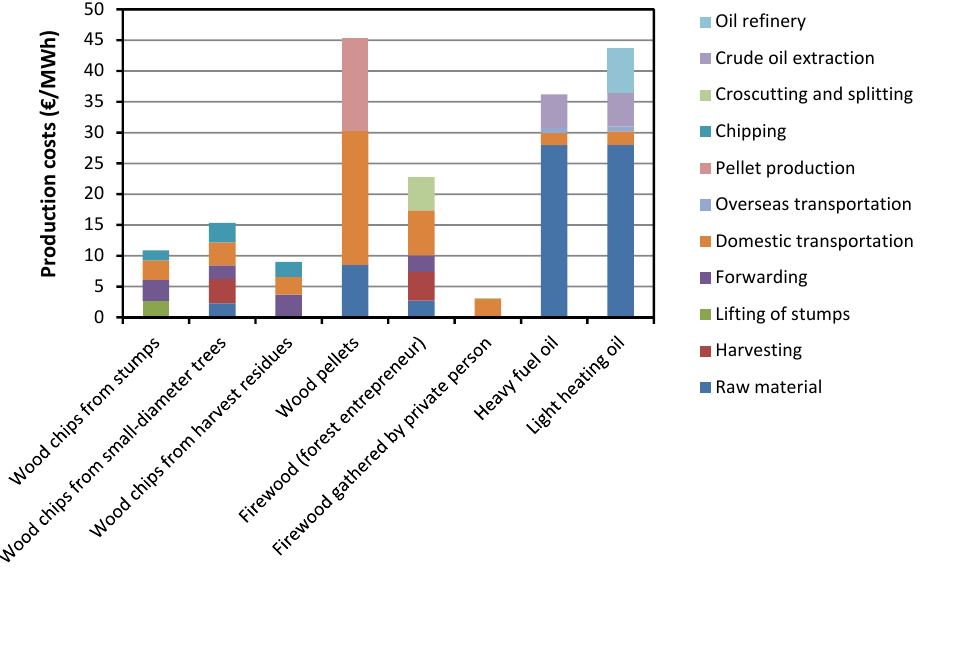
Figure 2. Production costs (€/MWh) of wood chips, pellets, firewood and oil in 2005. Note that the production costs for oil procurement occur outside North